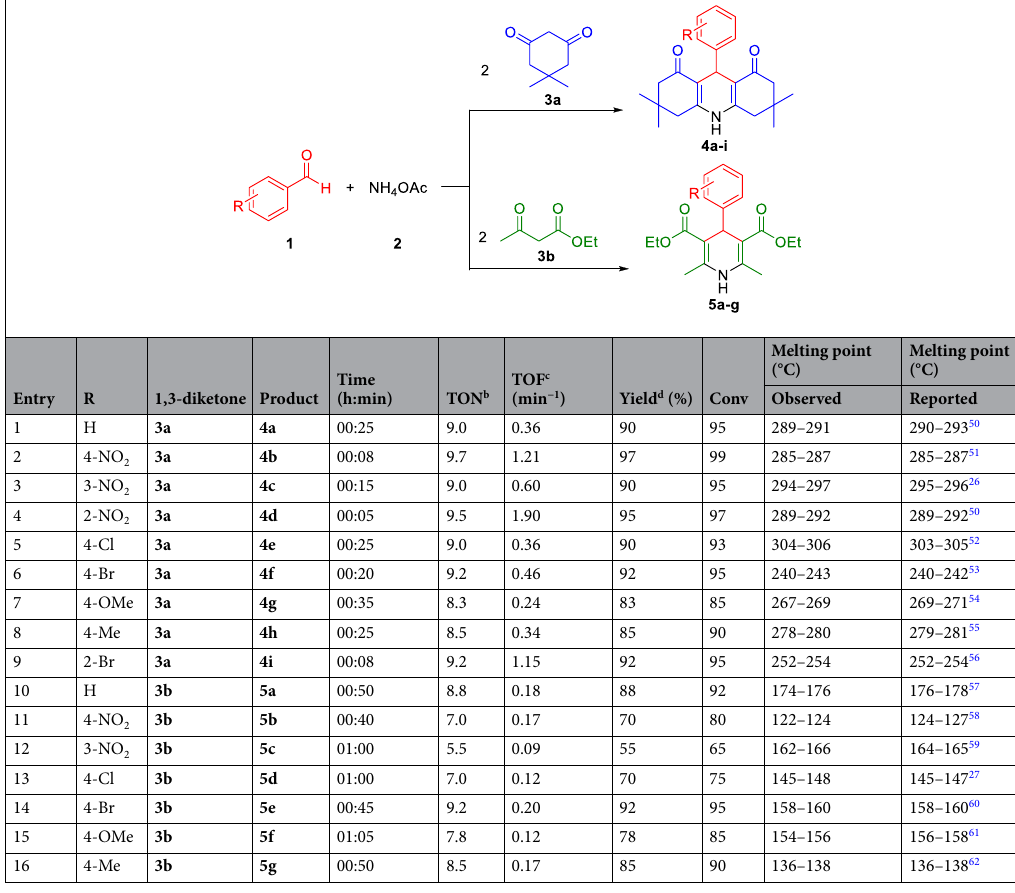
Table 1. One-pot synthesis of 1,8-DOXDHA and 1,4-DHP a . a Reaction conditions: aldehydes (1.0 mmol),